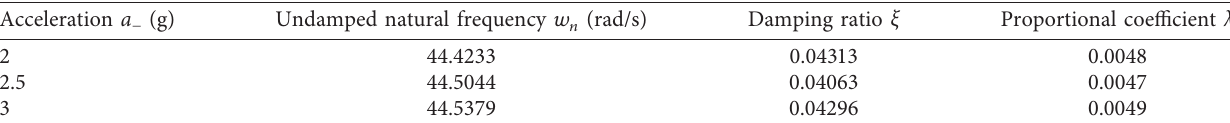
Figure 10: ARMA recognition results of trapezoidal move profile impact with V a − � 3g. Table 2: ARMA recognition results of triangle move profile impact.